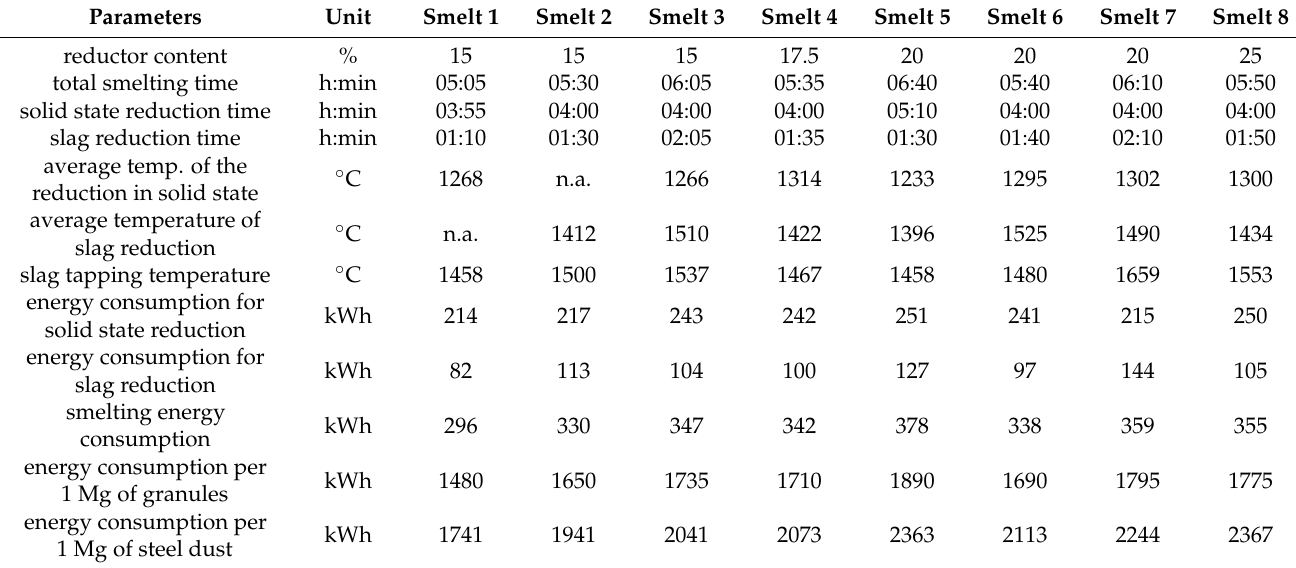
Table 2. Smelting